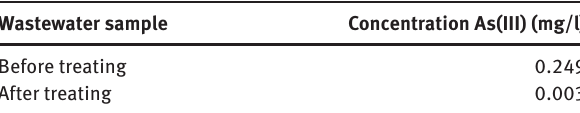
Table 1: Characteristics of the wastewater sample from Suoi Cat spring. Wastewater